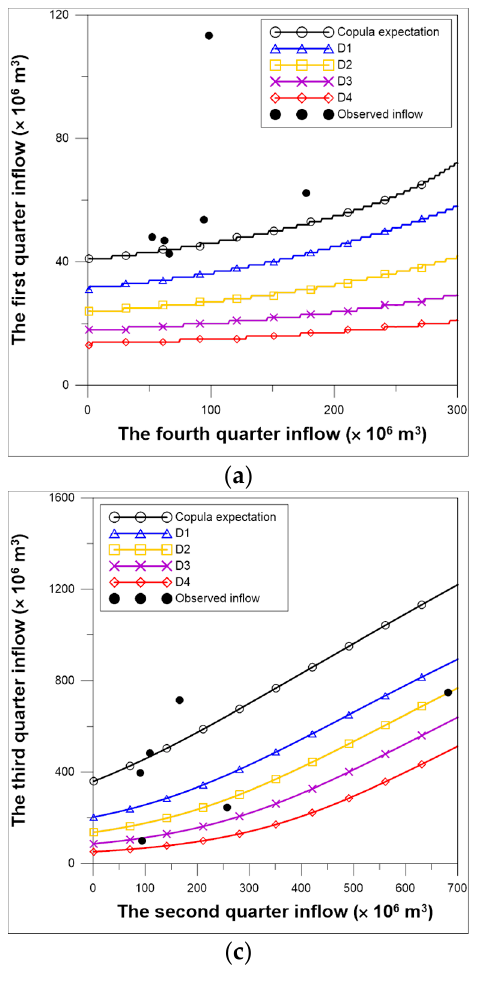
Figure 10. Quarterly inflow forecasting curves conforming to drought stages for the Andong dam: ( a ) first quarter; ( b ) second quarter; ( c ) third quarter; and ( d ) fourth quarter.